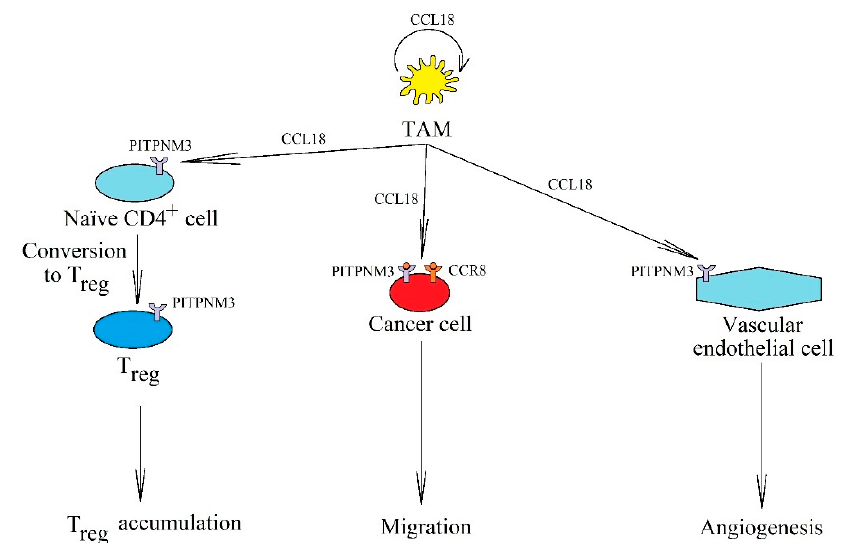
Figure 6. The significance of CCL18 in cancer processes. In a tumor, it is produced and secreted by TAM, where it acts on these cells in an autocrine manner. It also causes cancer cell migration and invasion via receptors PITPNM3 and CCR8. CCL18 is important in angiogenesis by acting on PITPNM3 on endothelial cells. It also causes the recruitment of naïve CD4 + T cells into the tumor